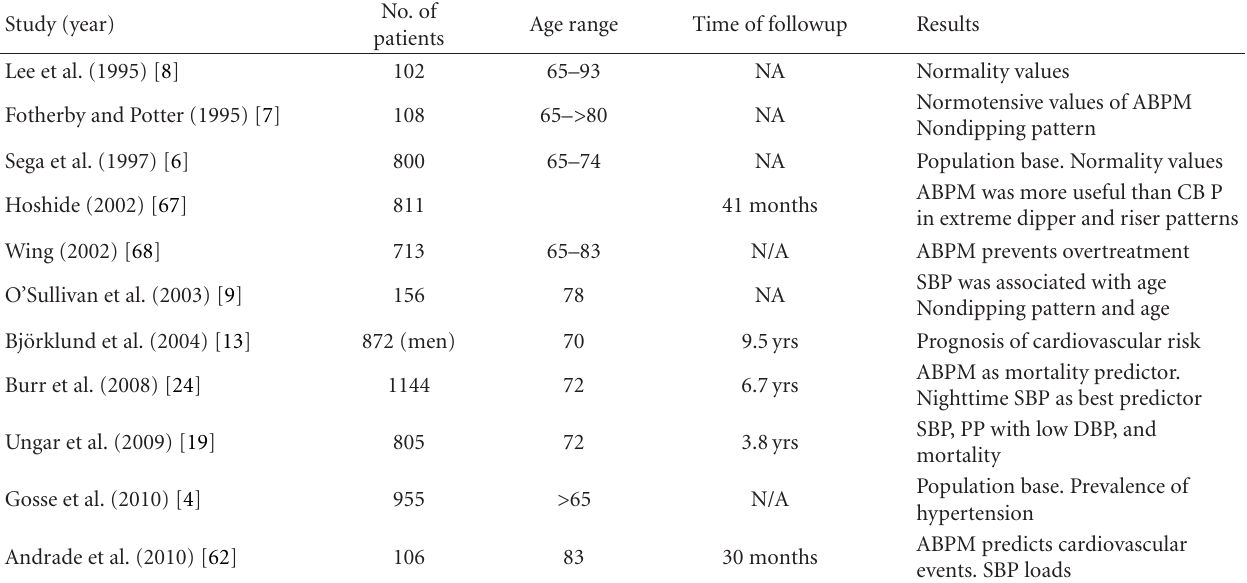
Table 2: Studies published on ABPM in subjects older than 65